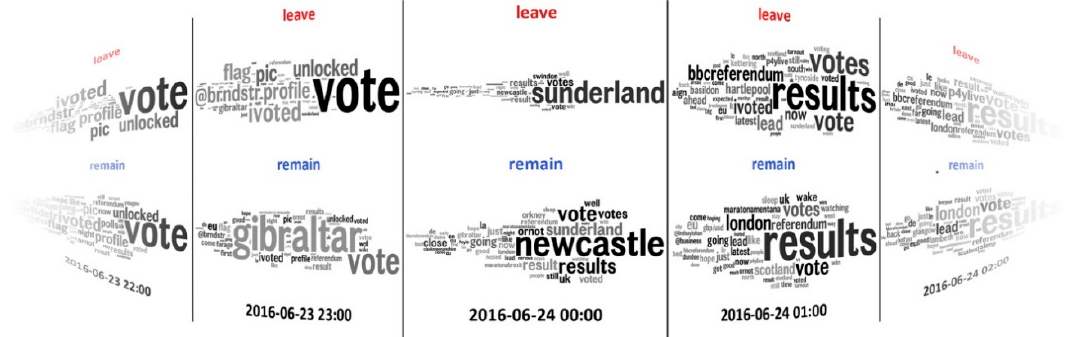
Figure 5. Word clouds generated out of leave -related and remain -related tweets for one-hour timeframes.